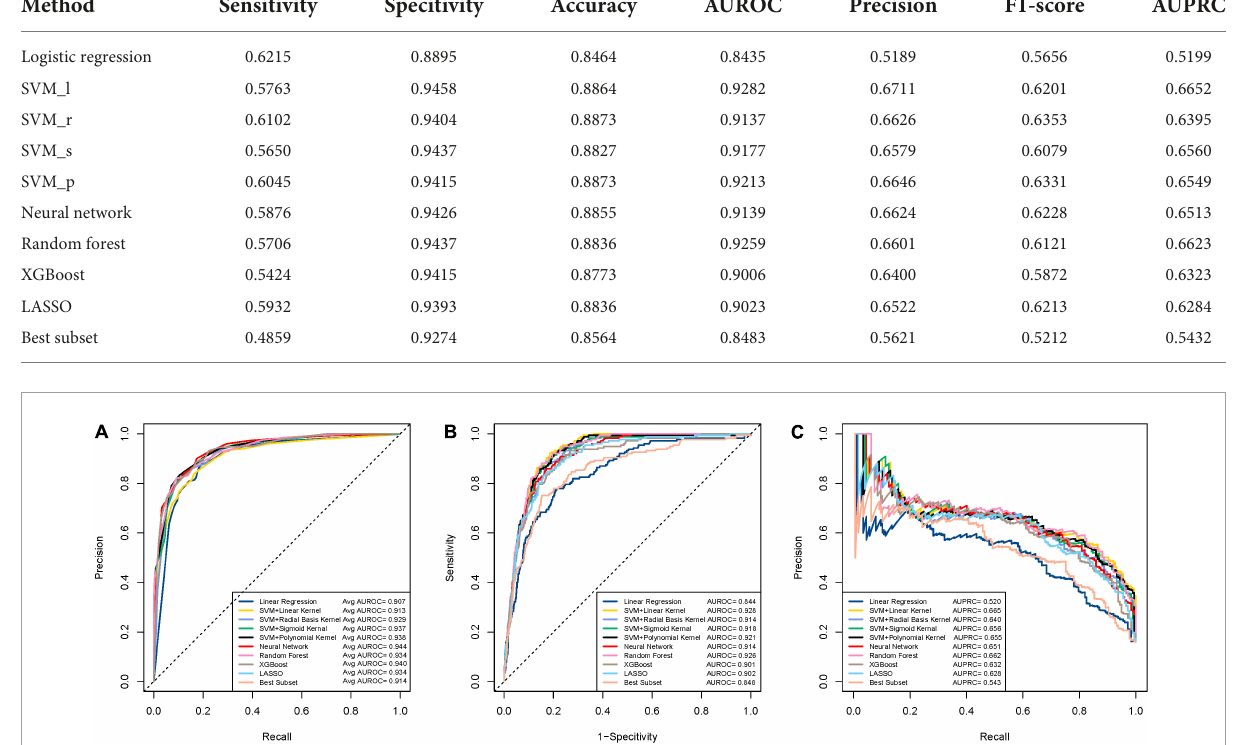
TABLE 3 Classification performance of each model evaluated externally on the community dataset.